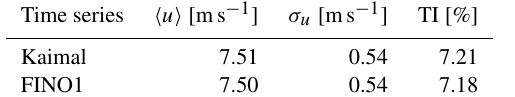
Table 1. First two statistical moments and turbulence intensities of a synthetic wind speed time series based on the Kaimal model and offshore data (FINO1). Values are rounded to two decimal places.